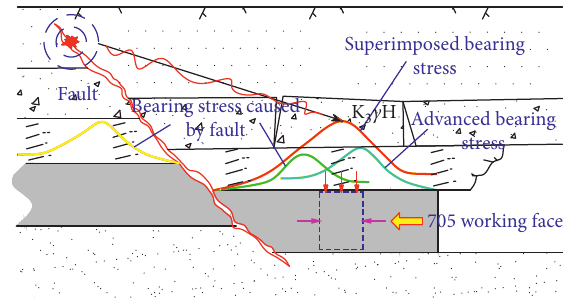
Figure 6: Simplified model of No. 705 working face going through